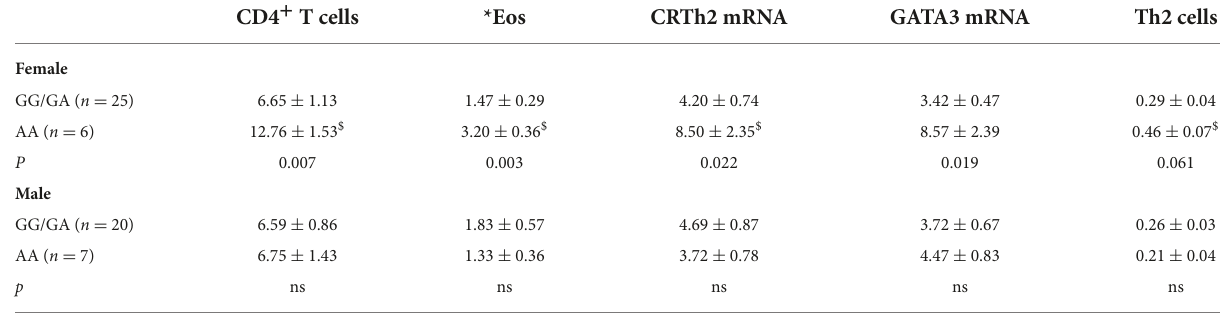
TABLE 2 Association of CRTh2 rs533116 G > A with type 2 inflammation in all asthmatics.